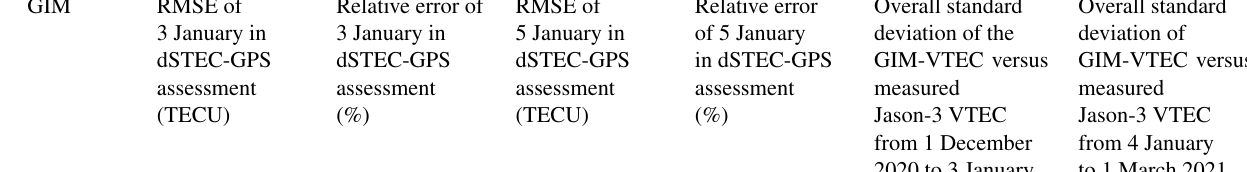
Table 4. Standard deviation of GIM-VTEC minus Jason-3 VTEC in Jason-3 VTEC assessment (last two columns) and dSTEC-GPS assess- ment results of RT-GIMs on 3 January (second and third columns) and 5 January (fourth and fifth columns) in